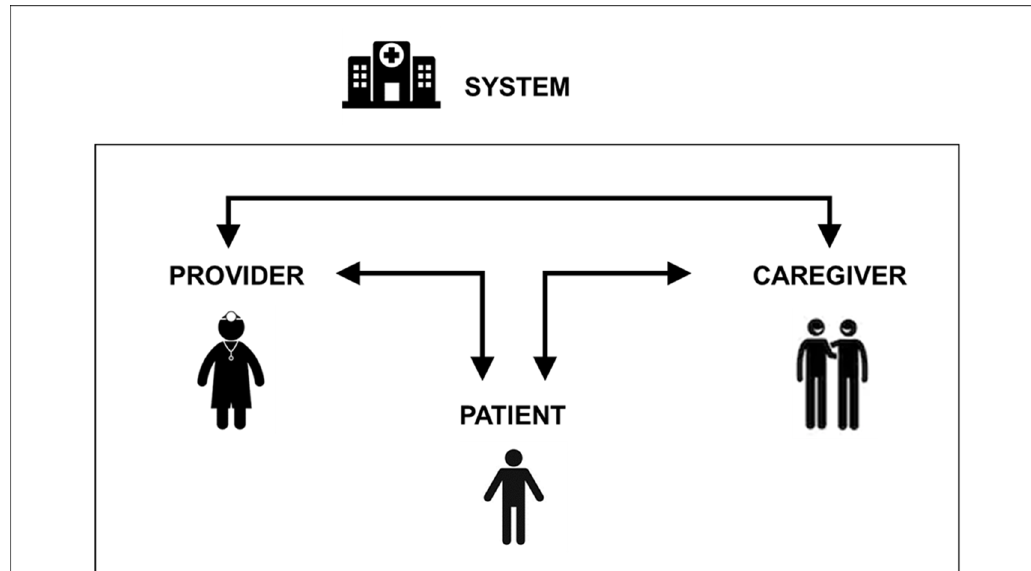
Figure 1. The barriers to older adult participation in cancer clinical trials are multifaceted and interrelated, with barriers existing at the system, clinician, patient, and caregiver levels. System- related barriers include trial design, overly stringent eligibility criteria, and lack of infrastructure support, appropriate and representative trials, and funding. Clinician-related barriers include concerns for side effects or toxicities, patient age, comorbid conditions, personal bias, costs to clinicians, and lack of time, support and staff, awareness of trials, and engagement amongst clinicians. Patient-related barriers include attitudes towards clinical trials, knowledge, side effects/toxicities, burden, and financial limitations. Caregiver-related barriers include caregiver burden and preference against